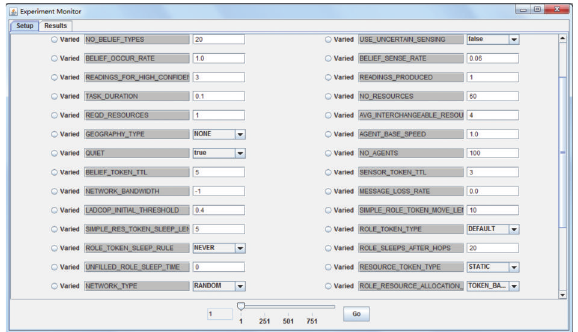
Figure 4: CoordSim allows a large number of parameters to be varied and also allows statistics to be